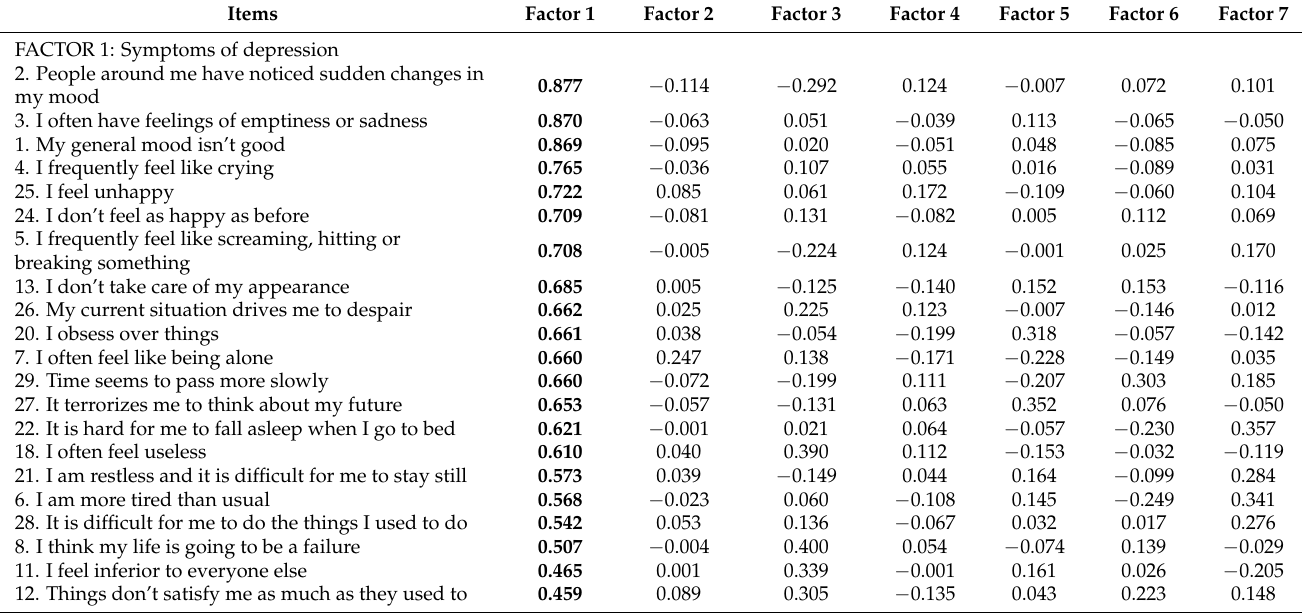
Table 2. Factor loading matrix after Promax